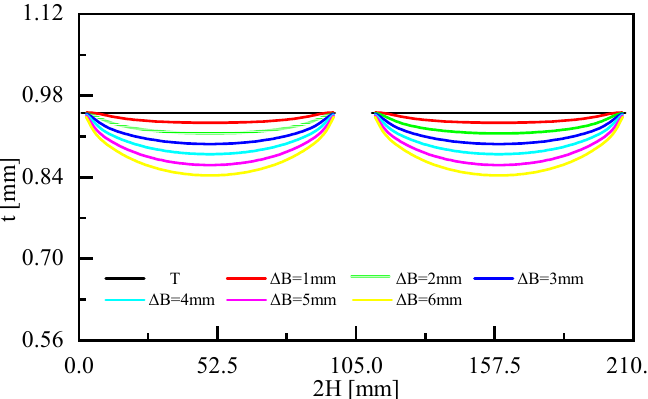
Figure 12. Thickness distributions of the bi-segment bulged hulls obtained from numerical analysis.